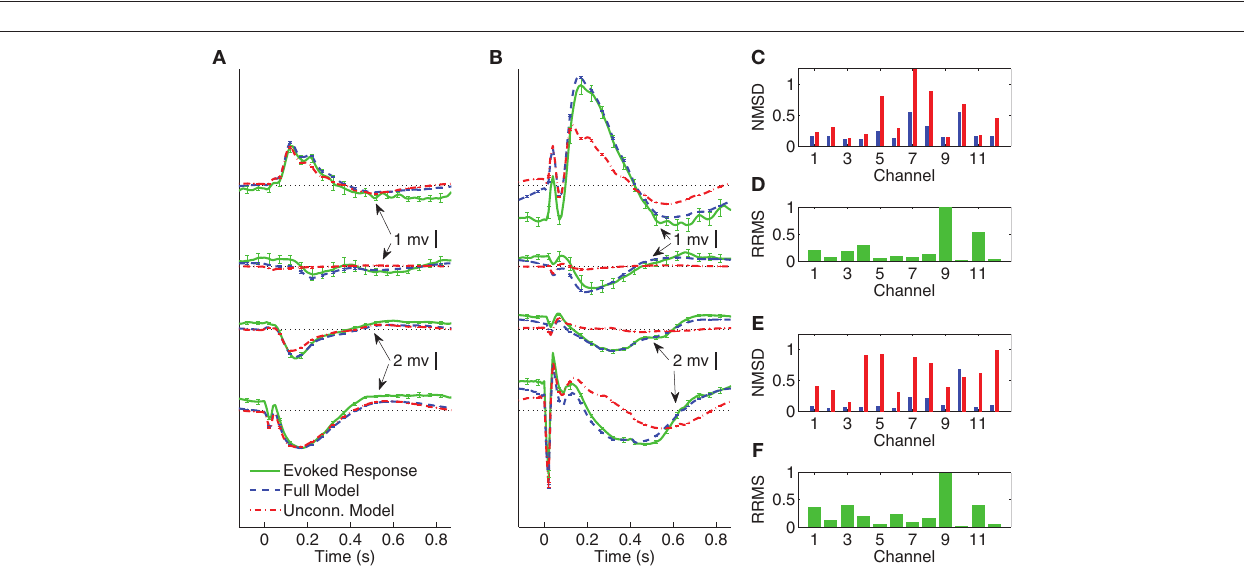
responses of channels 1, 7, 4, and 11 with 5mA current stimulation. (C) Normalized mean-squared difference in each channel for 1mA stimulation. (D) Relative root mean-squared energy in each channel for 1mA stimulation. (E) Normalized mean-squared difference in each channel for 5mA stimulation. (F) Relative root mean-squared energy in each channel for 5mA stimulation.